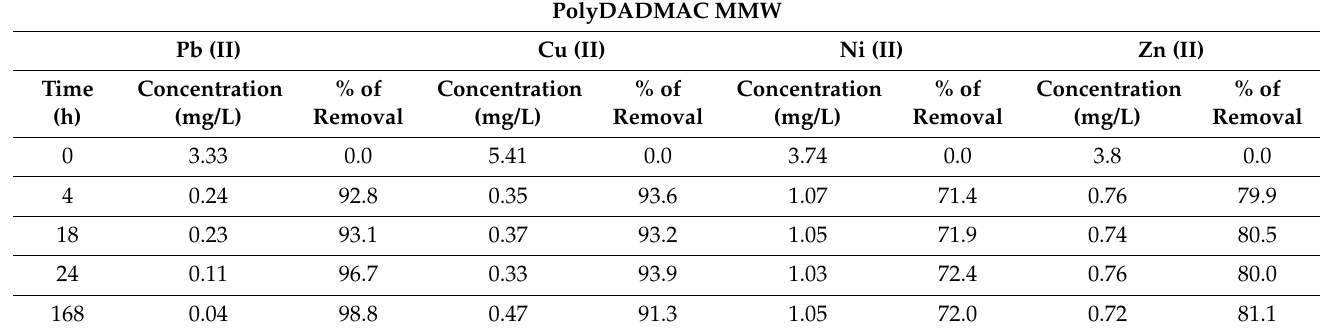
Table 5. Removal of Pb(II), Cu (II), Ni (II) and Zn (II) by a suspension of 0.01% ( w / w ) of MWCNTs in a solution of 0.03% ( w / w ) of polyDADMAC MMW.